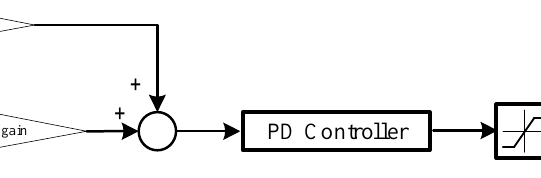
Figure 3. Error-cubic PD controller.